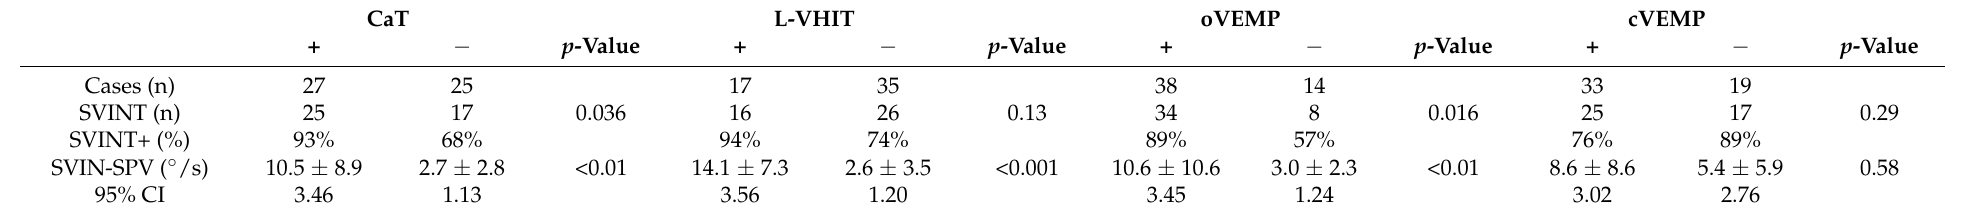
Table 3. SVIN presence and horizontal SPV value by result of different vestibular